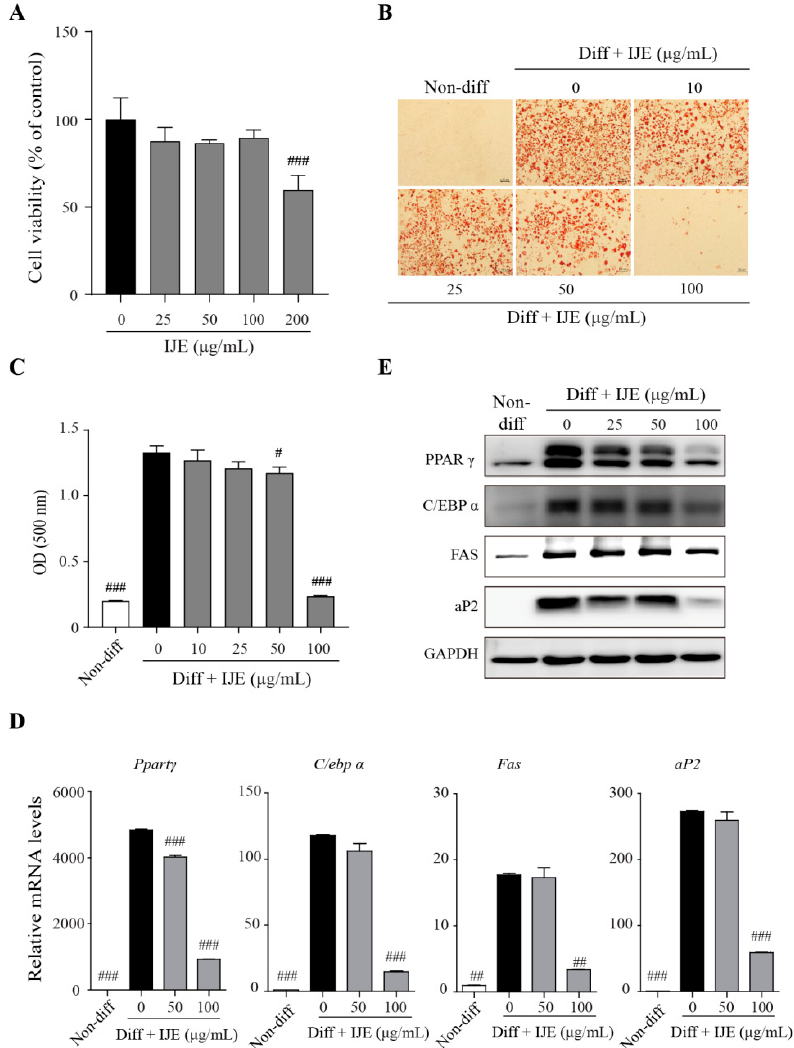
Figure 1. Effects of I. japonica flower ethanol extract (IJE) on adipogenic differentiation of 3T3-L1 cells. ( A ) The effects of IJE on cell viability were measured by the MTT assay. ( B ) Oil Red O staining of differentiated 3T3-L1 cells with or without IJE treatment was done (scale bar: 100 µ m), after which absorbance was measured at 500 nm in triplicate. ( C ) Optical density (OD). ( D ) Relative mRNA and ( E ) protein levels of PPAR γ , C/EBP α , FAS, and aP2. Data are presented mean ± standard deviation (SD) of triplicate experiments. #, ##, and ### indicate p < 0.05, 0.01, and 0.001, respectively, when compared to the group treated with differentiation (Diff) without IJE.